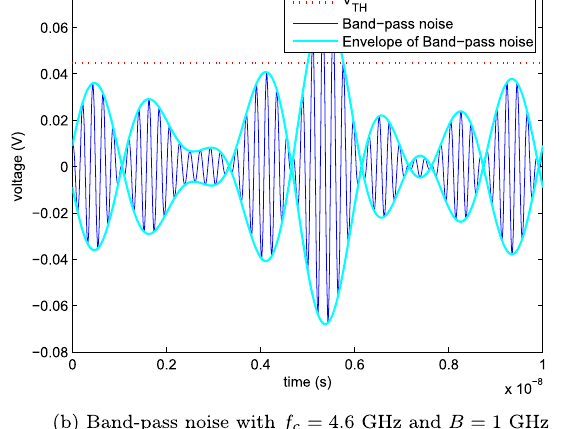
Fig. 3 Bandpass noise waveforms: a a waveform of BP noise with relatively large B / f c which corresponds to the case of (17), b a waveform of BP noise with relatively small B / f c which matches the case of